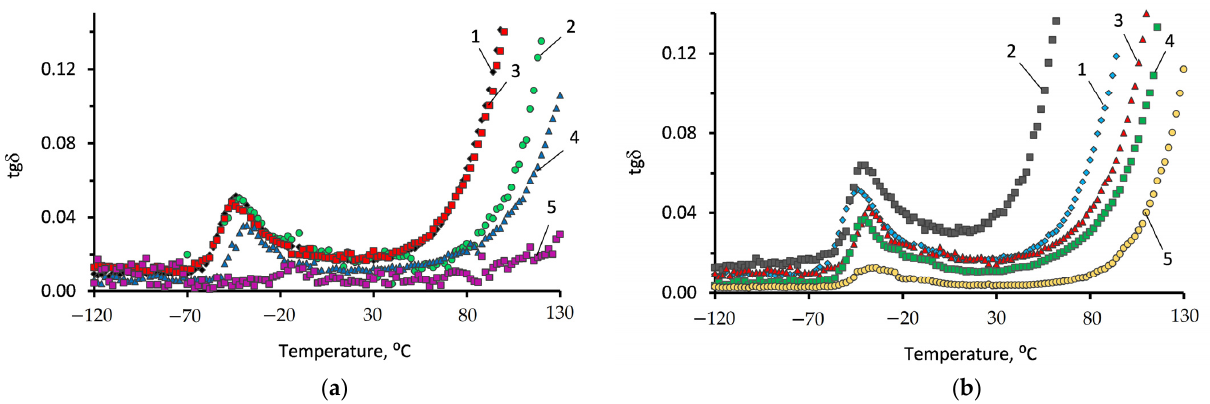
Figure 8. Temperature DLT dependences of polymers modified by the ASiP–AGM-10 ( a ) and the ASiP–AGM-50 ( b ) with their content: 0.0 (1), 0.05 (2), 0.10 (3), 0.20 (4) and 0.30 (5) wt.%.